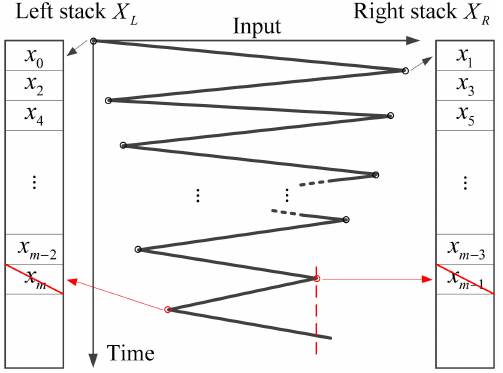
Figure 4. Determination of the current turning point using the wiping-out property.